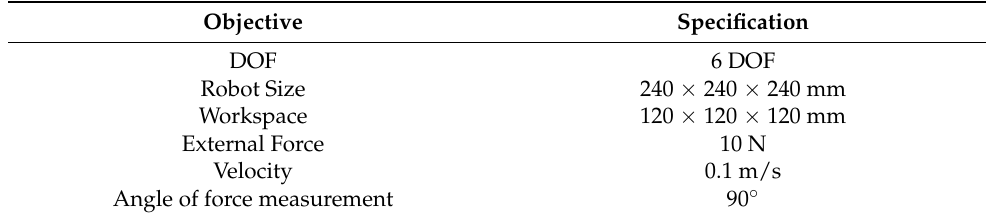
Table 1. Established specifications of the proposed haptic